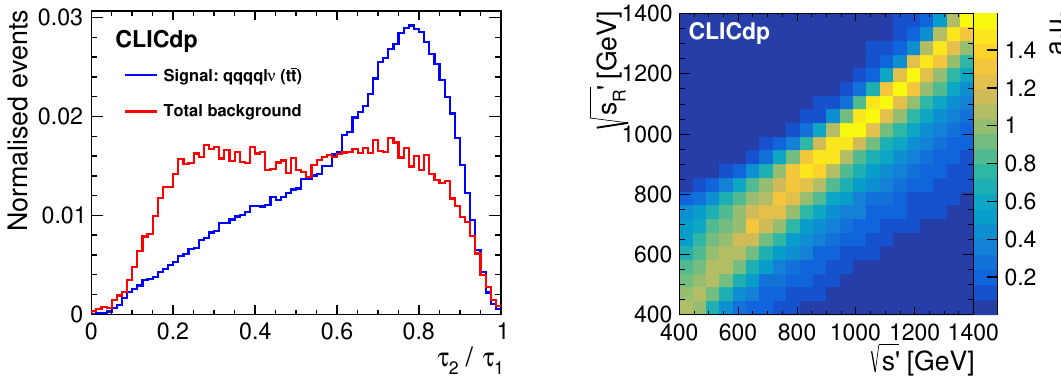
Figure 18. The N-subjettiness ratio (cid:28) =(cid:28) for the leptonically decaying large- R jet (left). Recon- 2 1 p structed centre-of-mass energy s 0 from kinematic (cid:12)tting vs the generated collision energy, R including the e(cid:11)ects of the luminosity spectrum and ISR (right). To illustrate the correlation down p p to lower s 0 , the s 0 distribution is reweighted so that each column contains the same number of p entries, leading to a (cid:13)at distribution in s 0